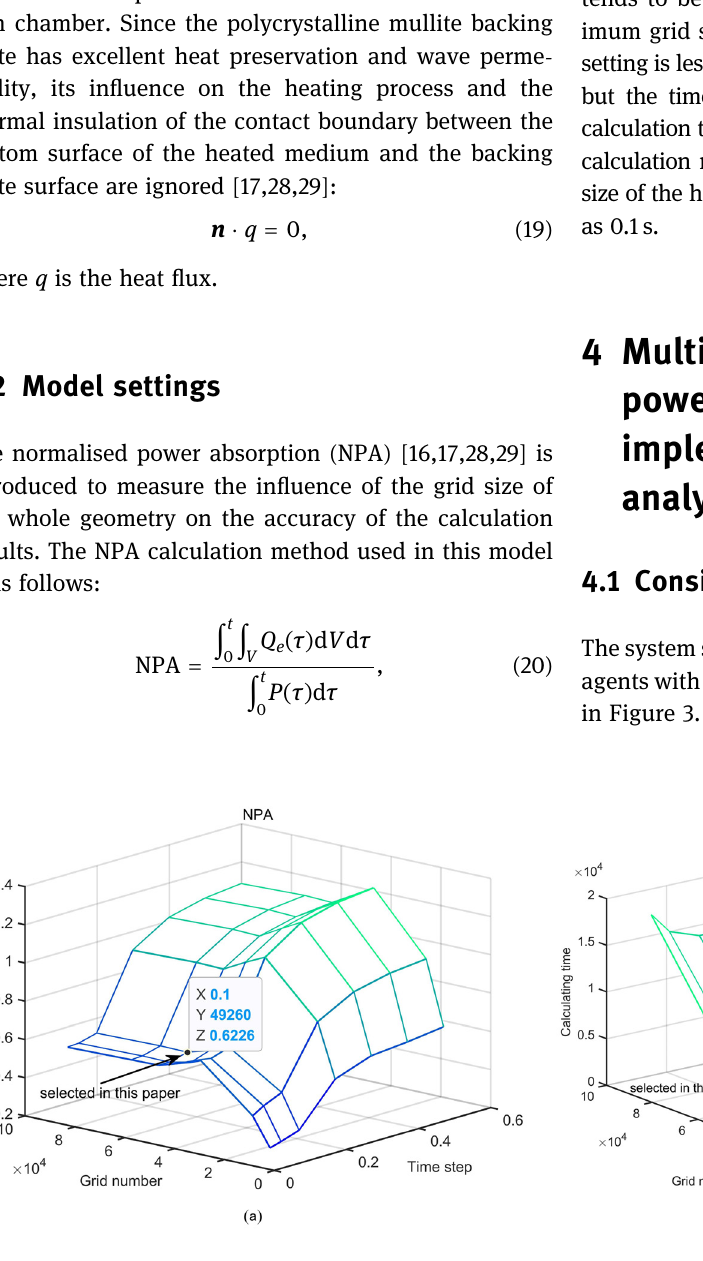
Figure 2: ( a ) NPA variation with di ff erent numbers of grids and time steps and ( b ) computational time variation with di ff erent numbers of grids and time